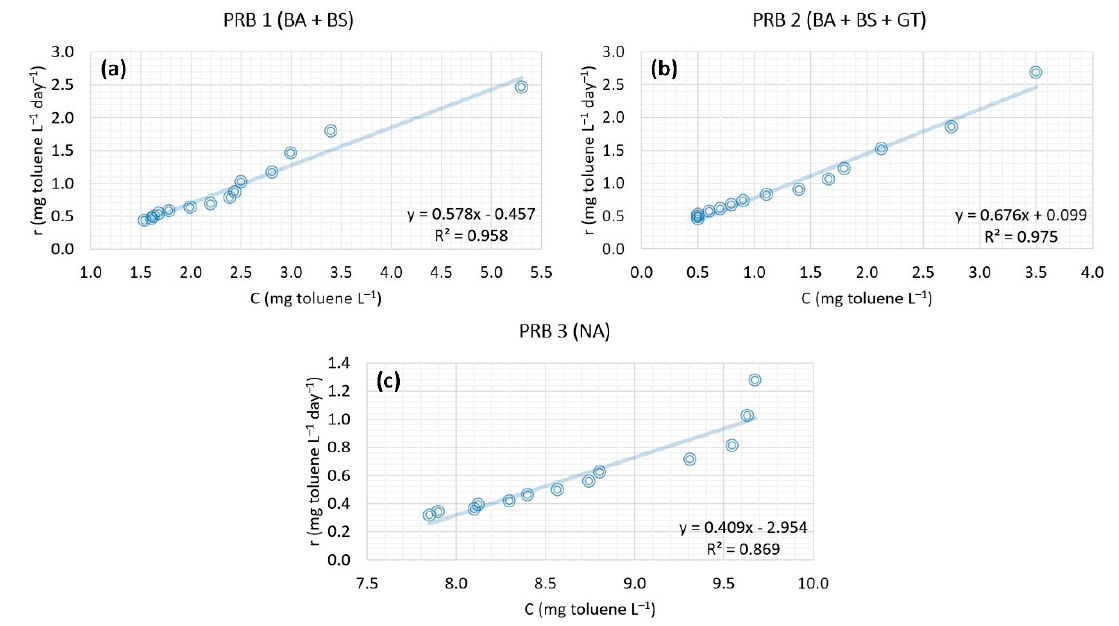
Figure 11. Reaction rate data for the PRB toluene treatment processes for phase 3: ( a ) The first-order model for PRB-1, ( b ) the first-order model for PRB-2, and ( c ) the first-order model for PRB-3.